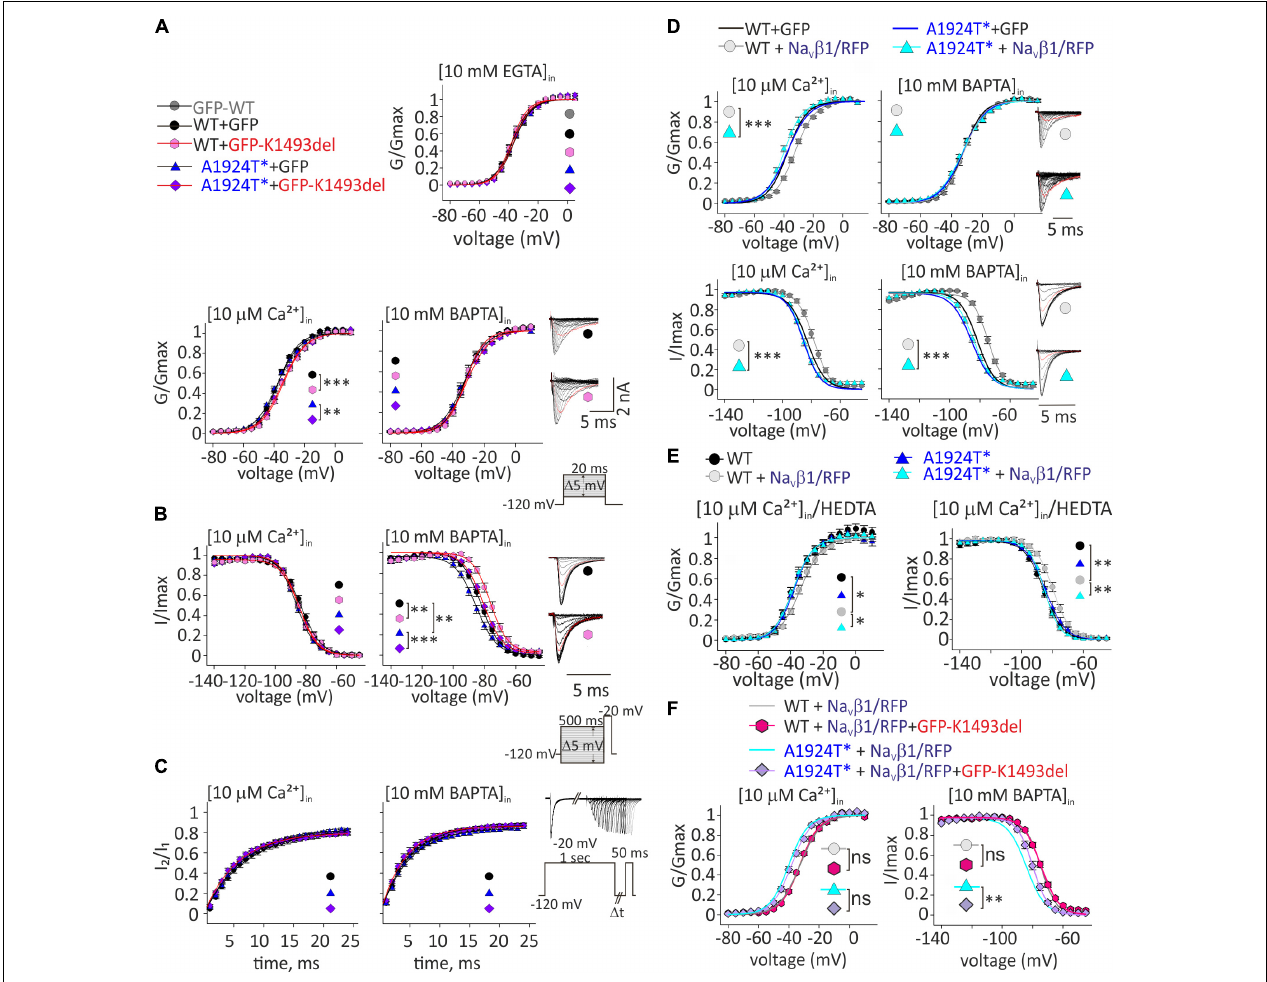
FIGURE 4 | Ca 2 + -dependent gating properties of Na V 1.5 variants. (A) Activation curves of conductance-voltage relationship. Current traces recorded in [10 µ M Ca 2 + ] in , and –40 mV trace is red. (B) SSI curves of voltage-dependent channel availability. Current traces during the test pulse at –20 mV are with (10 mM BAPTA) in . The test-pulse trace that follows –80 mV pre-pulse is red. (C) Recovery from inactivation. (D) Activation (top) and SSI (bottom) curves of Na V 1.5 WT +GFP and Na V 1.5 A1924T ∗ +GFP co-expressing rNa V β 1/RFP were plotted with the fitted curves of these groups without rNa V β 1/RFP (presented in A , B ). Current traces recorded in [10 µ M Ca 2 + ] in . The –40 mV trace during activation and the test-pulse that follows the –80 mV pre-pulse during SSI are red. (E) Activation (left) and SSI (right) curves with 10 µ M Ca 2 + chelated with HEDTA in the internal solution. (F) Activation (left) and SSI (right) curves of Na V 1.5 variants co-expressing rNa V β 1/RFP and GFP-Na V 1.5 K1493del were plotted with the fitted curves of these groups without GFP-Na V 1.5 K1493del (presented in D ). Statistical significance of Va was determined by t -test: ns, not significant; ∗ p < 0.05; ∗∗ p < 0.01; ∗∗∗ , p < 0.001 (see Table 2